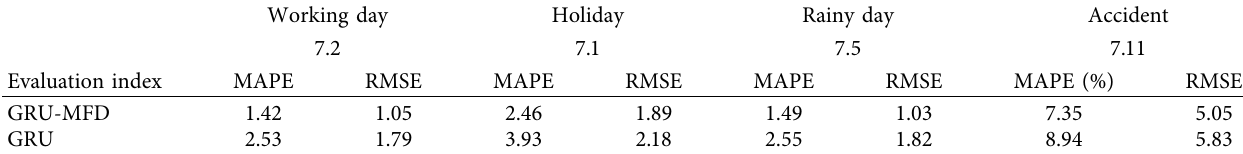
Table 6: Section 2 prediction